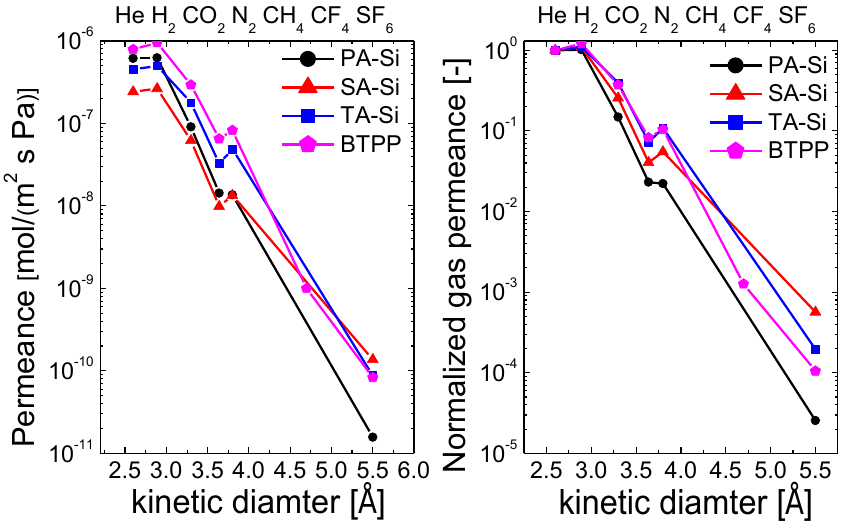
Figure 13. Kinetic diameter dependence of gas permeance (left: actual permeance; right: normalized permeance) operated at 200 °C for amine-functionalized organosilica membranes. The gas permeances were normalized based on their He permeances as standards. Results were reorganized from refs. [21,22].